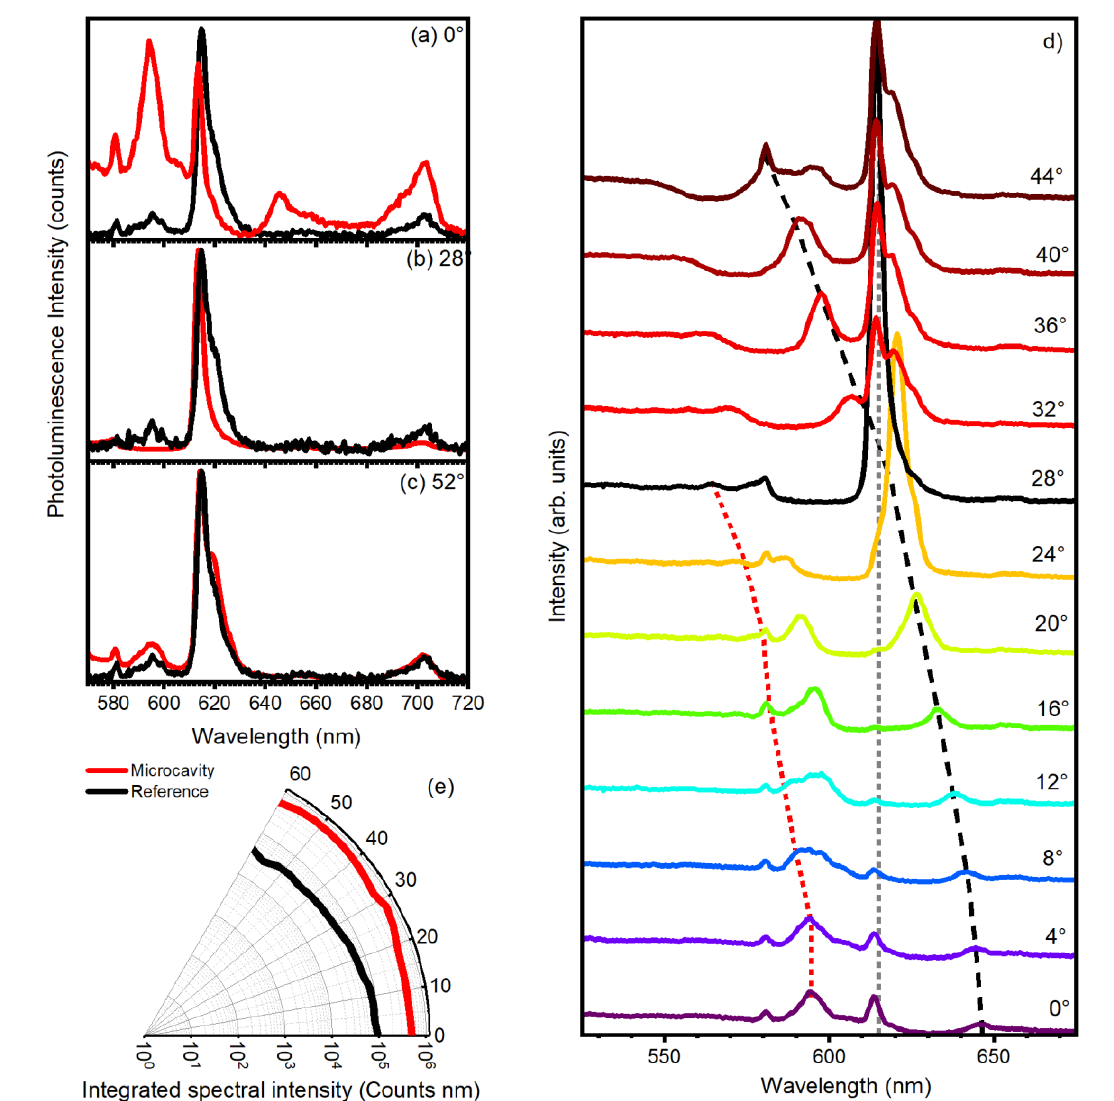
Figure 4. Normalized steady state emission spectra collected for the EuD 4 TEA microcavity (red line) and for the reference film (black line) collected at 0° ( a ), 28° ( b ) and 52° ( c ) with respect the normal incidence direction to the sample plane. ( d ) angular resolved emission spectra. ( e ) Angular resolved integrated spectral intensity for the reference and for the microcavity.